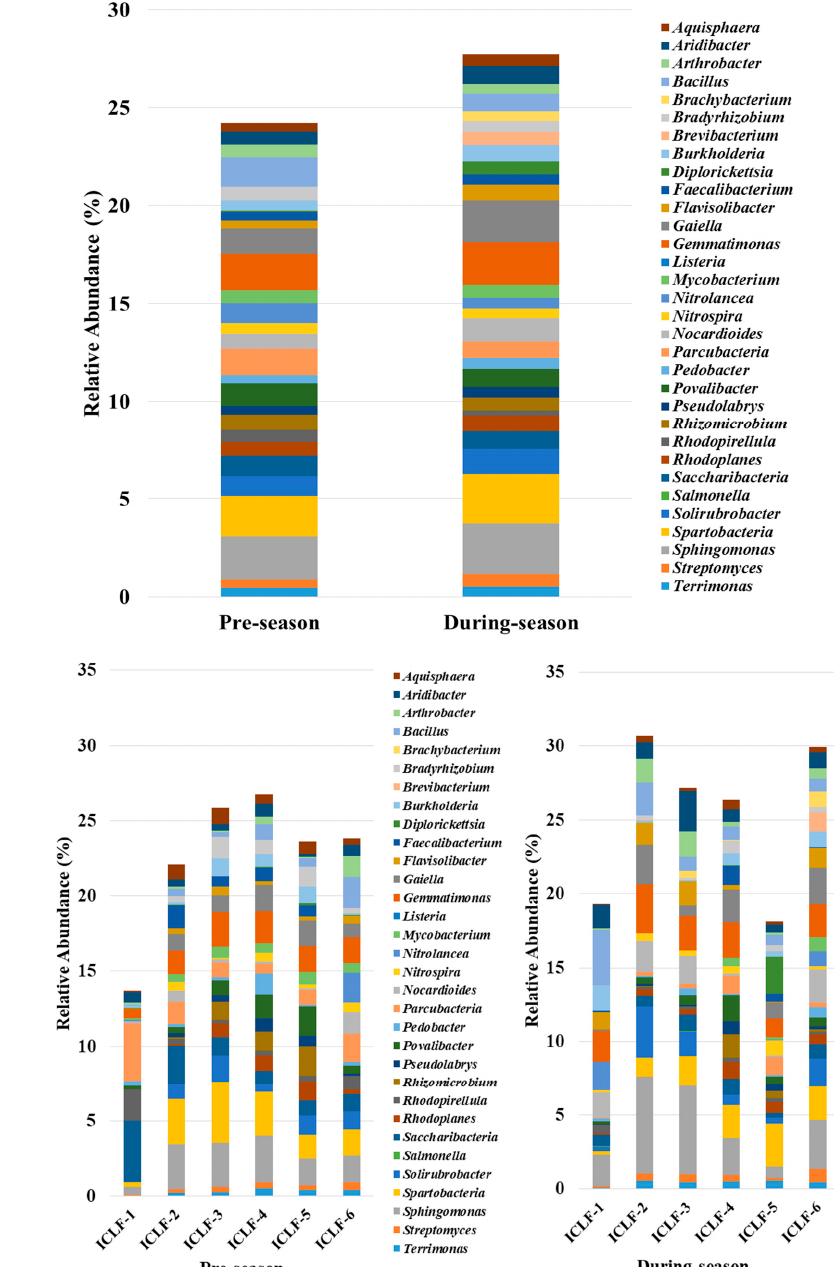
Figure 2. Relative abundances of the top-abundant soil bacterial genera before (in the left) and after (in the right) the application of animal manure product ( A ) combining all the six farms; ( B ) in different farms (ICLF 1 to ICLF6 represents individual